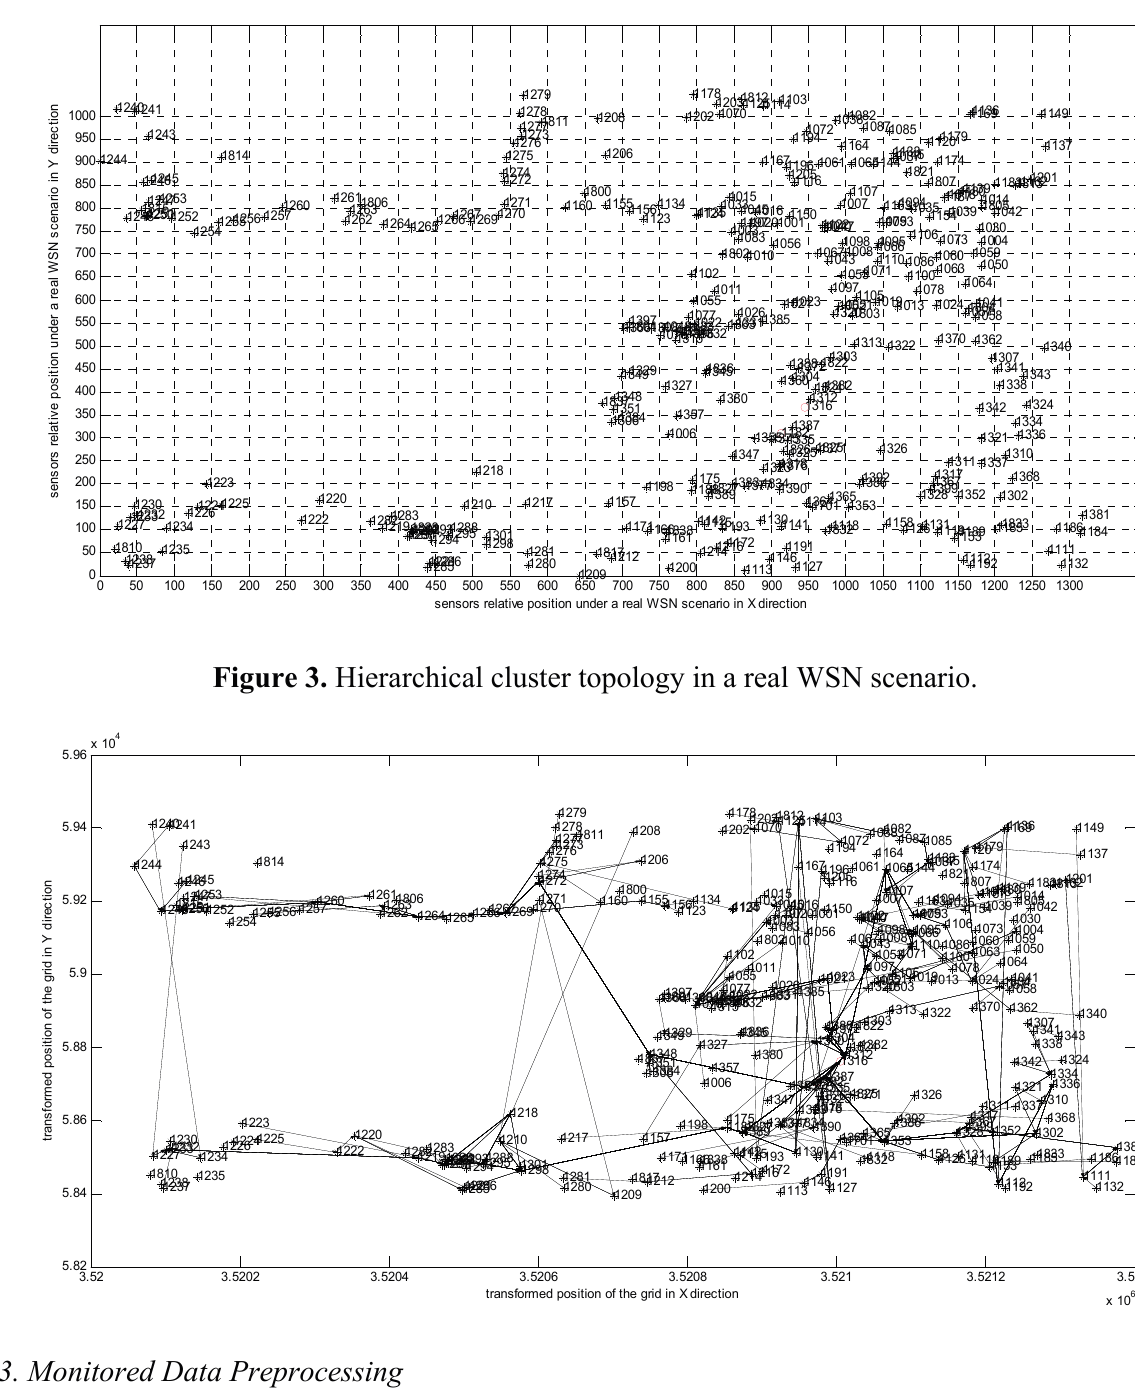
Figure 2. Deployment in a real WSN scenario.